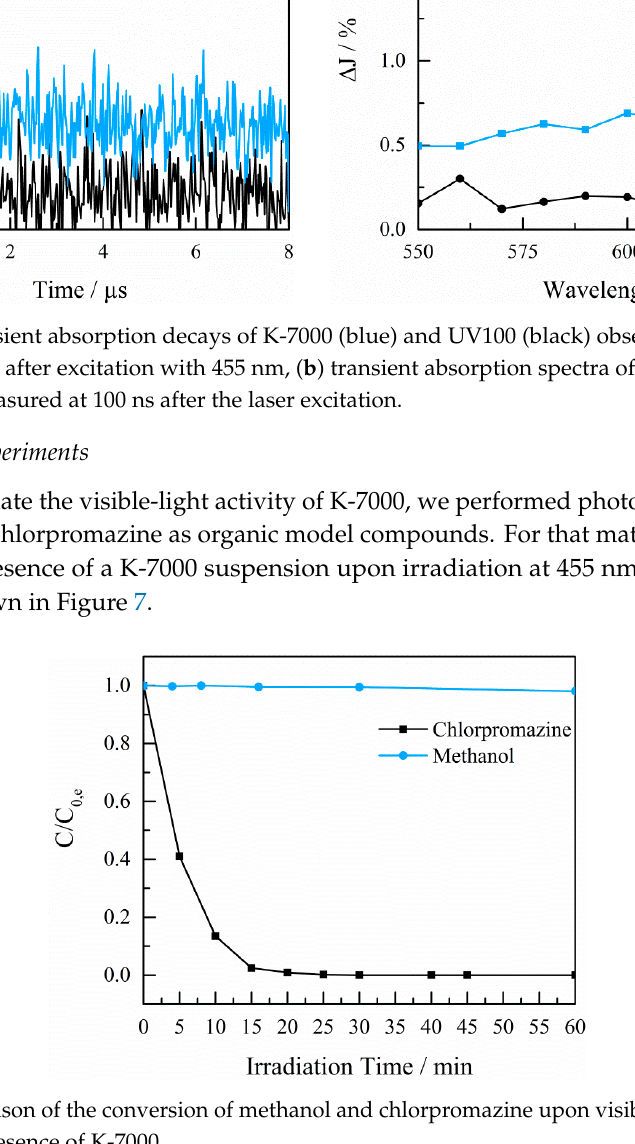
Figure 5. Transient absorption decays of K-7000 detected at 650 nm in an Ar (black), an O 2 (blue), and a methanol (red) atmosphere, after excitation with ( a ) 355 nm and ( b ) 455 nm.